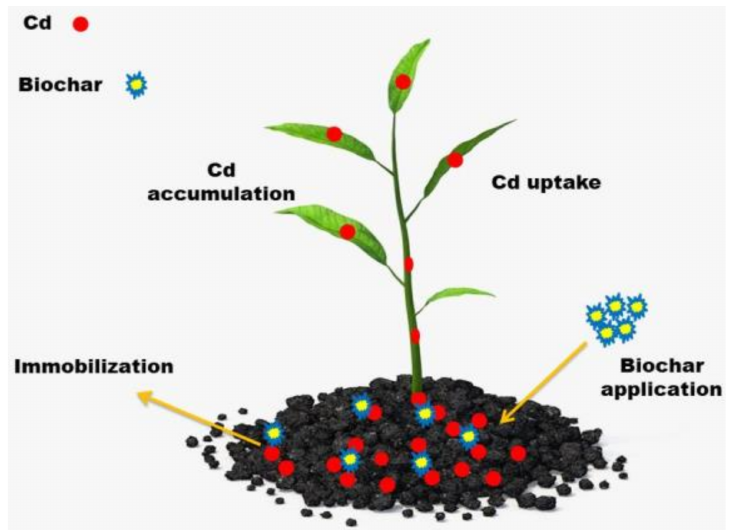
Figure 2. Uptake, accumulation and immobilization of Cd in soil by biochar-based